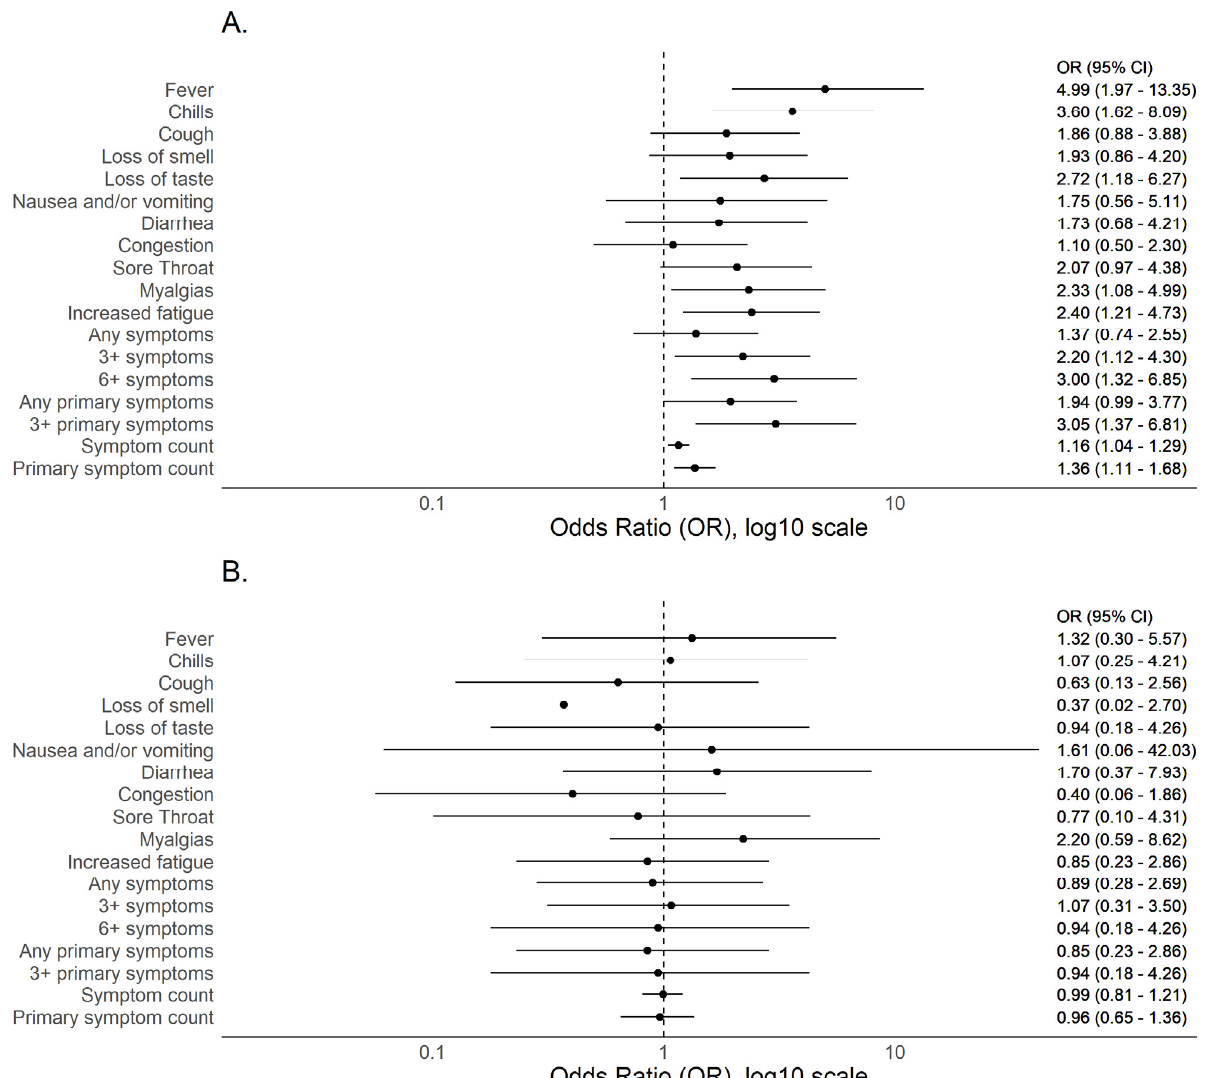
Figure 3. Forest plot of odds ratios of COVID-19 compatible symptoms among obese versus non-obese SARS-CoV-2 sero- positive individuals stratified by ( A ) <40 years ( n = 195) and ( B ) ≥ 40 years ( n = 67).